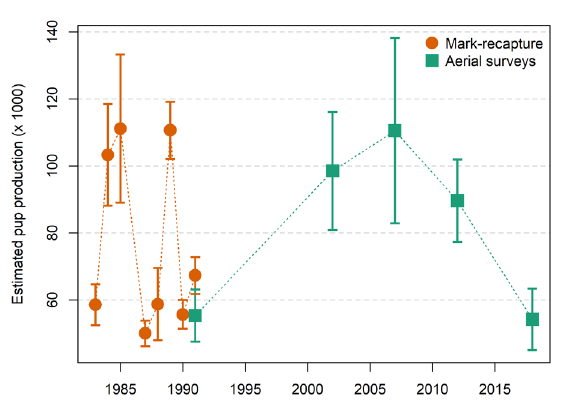
Figure 7. All pup production estimates obtained from harp seals since the start of surveys in 1977. Estimates based on mark-recapture experiments from 1977 to 1991 are shown in orange, while estimates based on aerial photo surveys are shown in